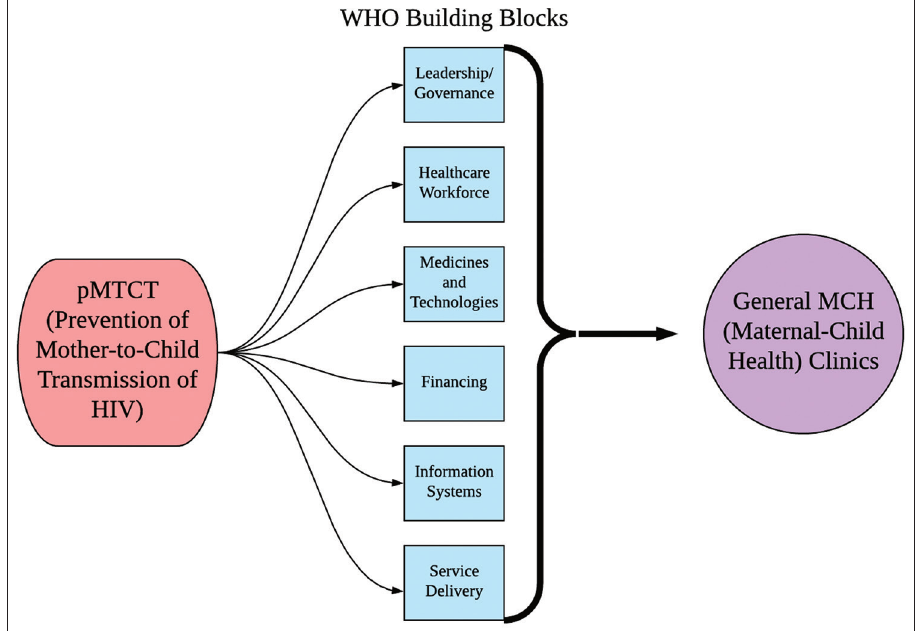
Figure 1: The World Health Organization Health Systems Framework Adapted to pMTCT – MCH